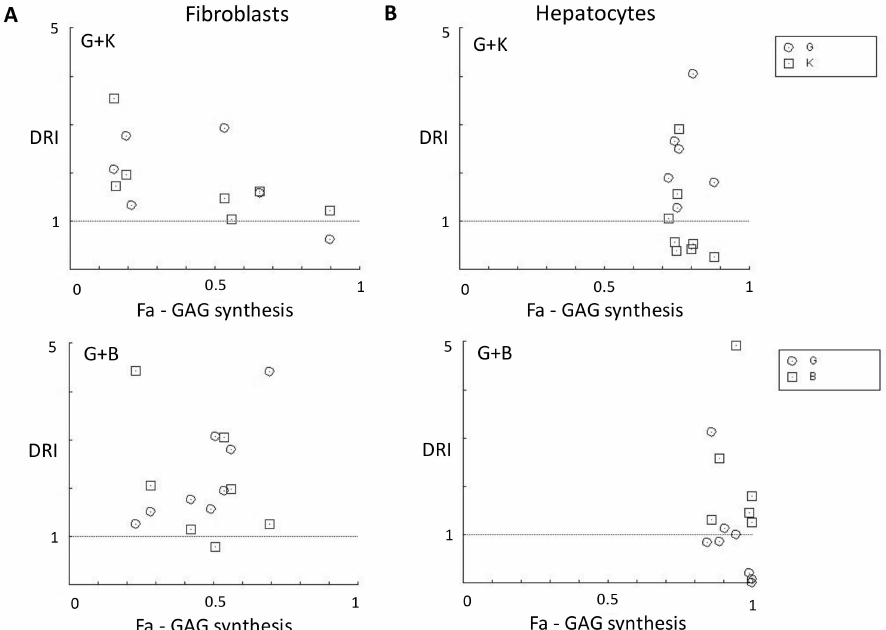
Figure 9. The dose reduction index (DRI) plots. DRI values are plotted against the fraction affected (Fa) values, i.e., the fraction of GAG synthesis inhibition after treatment of fibroblasts ( A ) and hepatocytes ( B ) with mixtures of genistein and biochanin A ( top graphs ) or genistein and kaempferol ( bottom graphs ). The dotted horizontal line represents no dose reduction; points plotted with DRI > 1 show favourable dose reduction and with DRI < 1—unfavourable dose reduction. Fa—fraction